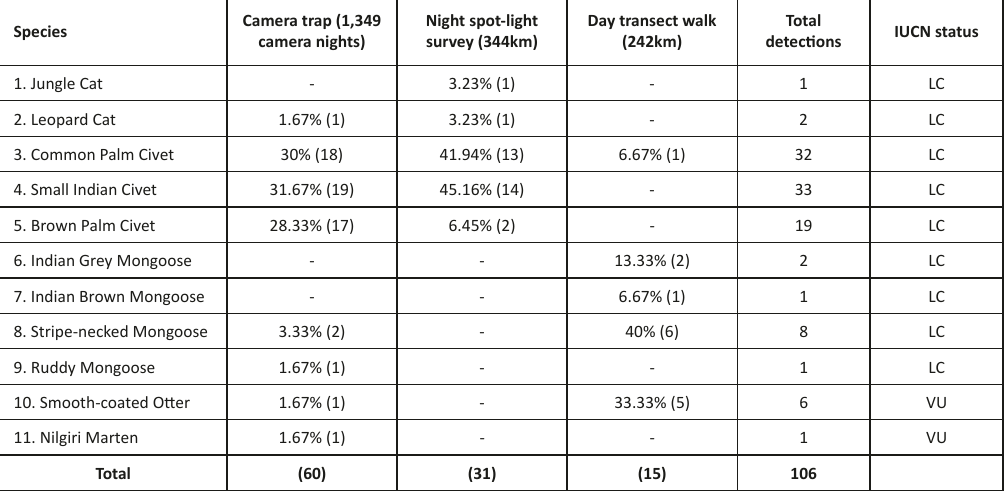
LC - Least Concern; VU -